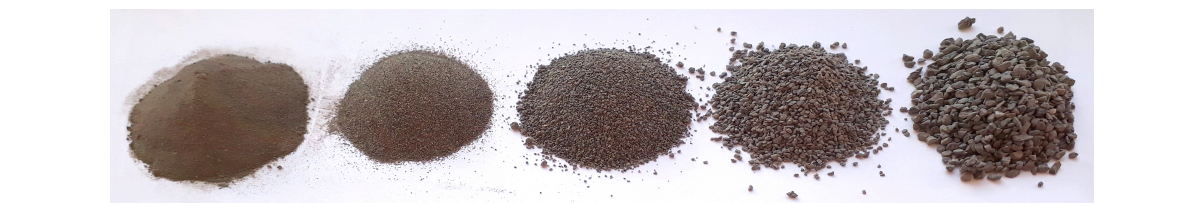
Figure 1. Stages of processing of the raw material during the experiment.